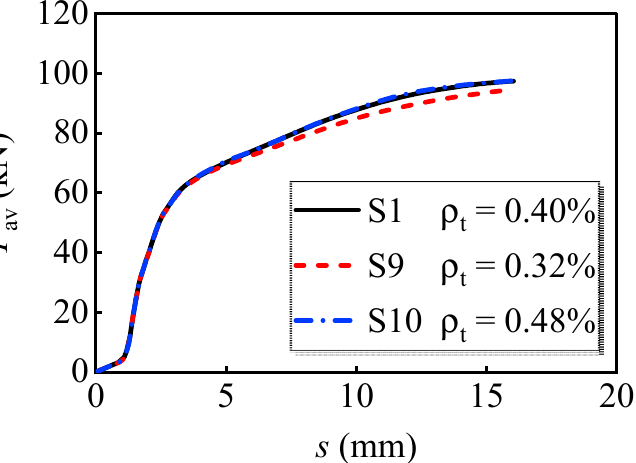
Figure 13. Variation of the load versus slip curves for models with different transverse reinforce- ment ratios.